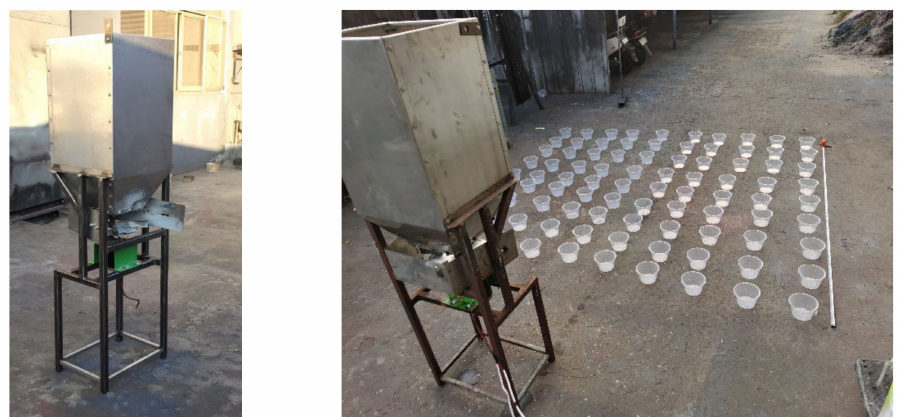
Figure 9. Bench test.